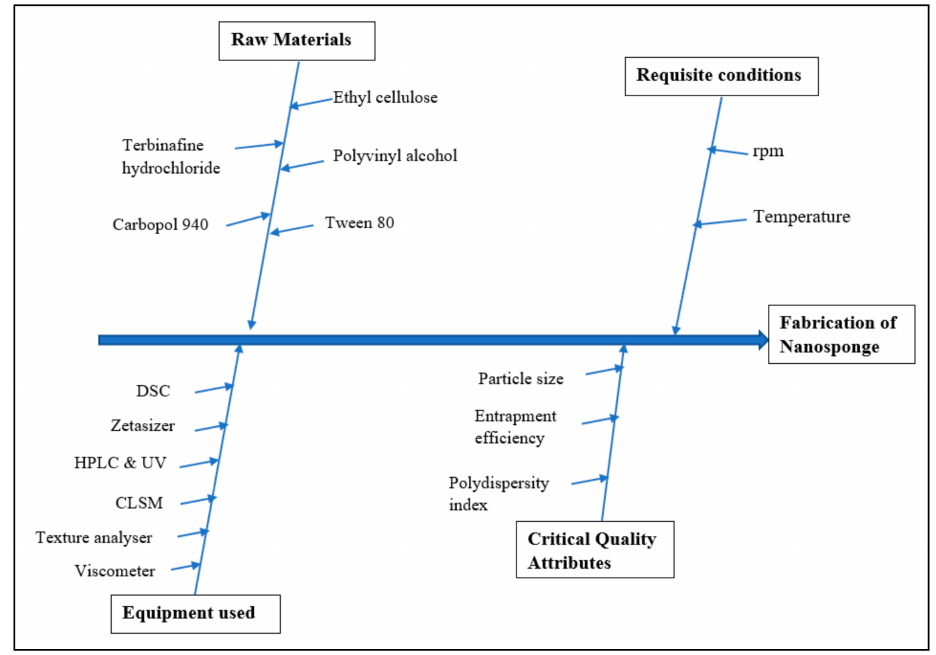
Figure 1. Ishikawa diagram used as a visualization tool for the fabrication of TH-NS.